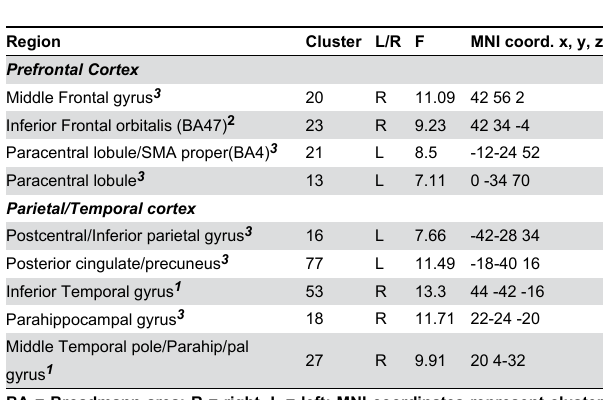
Table 6. Activations resulting from the Sstop>Go contrast One-way ANOVA (p <.005, k ≥ 13 voxels).